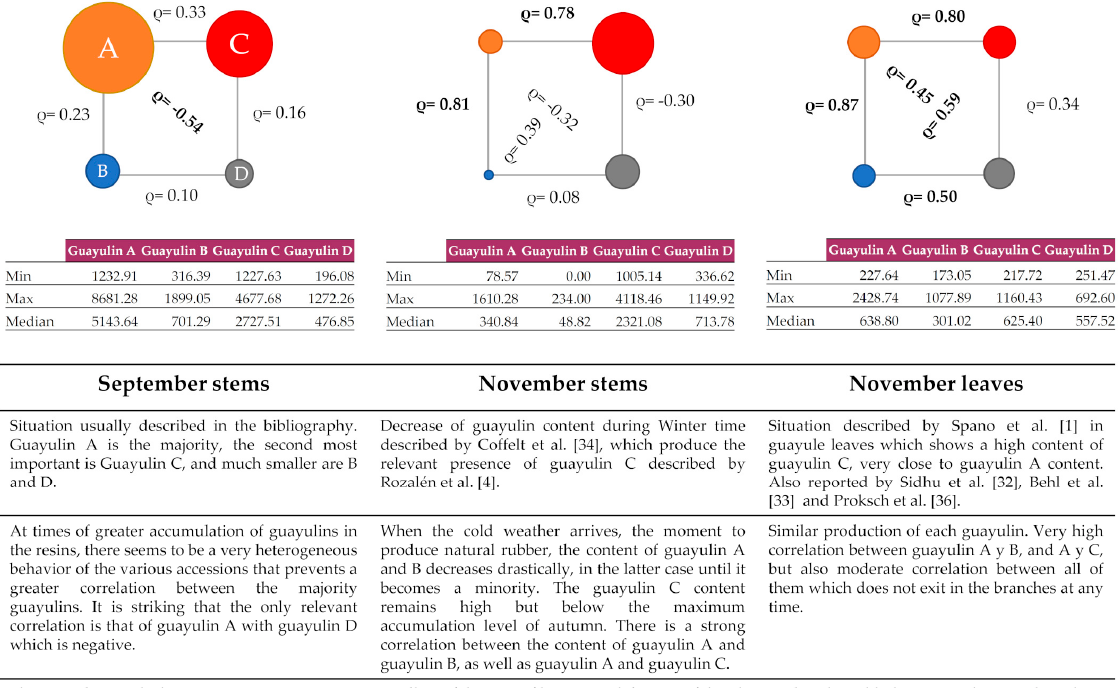
Figure 7. Summary diagram of the content of each guayulin in the various situations. Pearson’s correlation coefficient ( ρ ) is represented among the different circles that represent each guayulin. In the case of stems, all the circles are significantly different at a 95% confidence level when guayulin contents between September and November are compared by analysis of